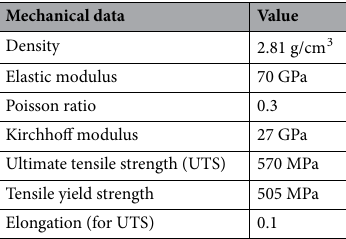
Table 3. Mechanical data of the 7075-T6 alloy 38–40 .